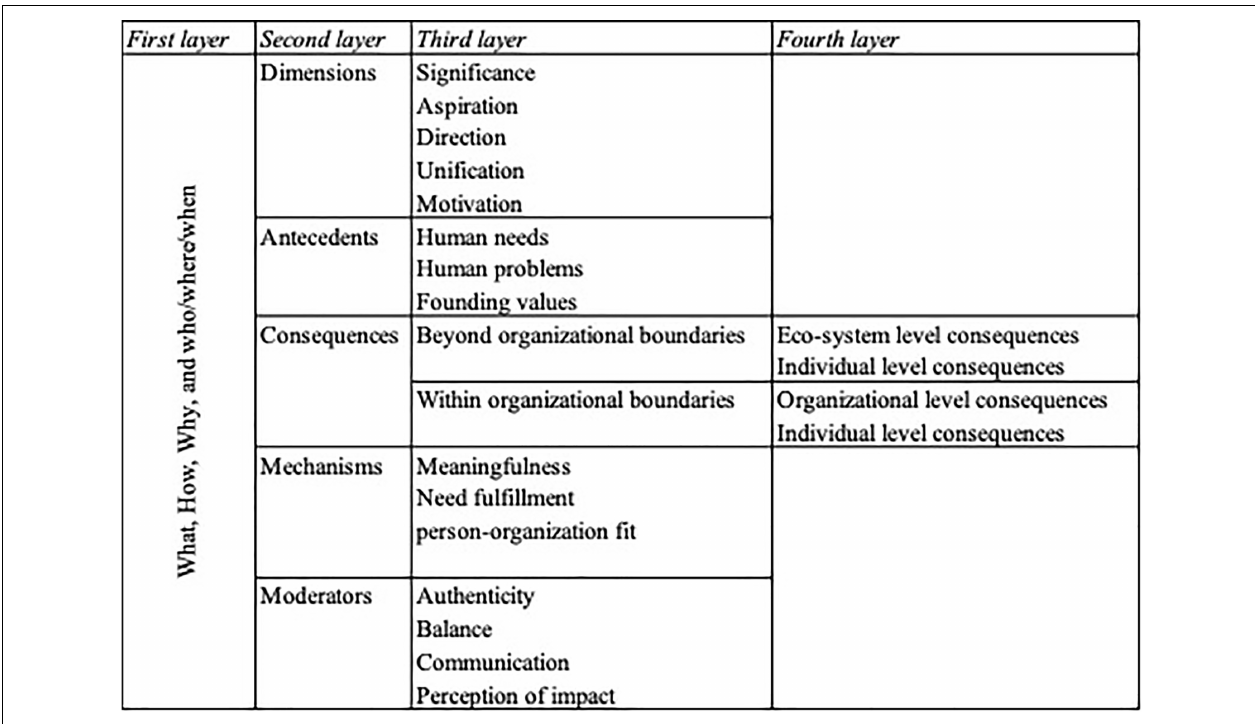
FIGURE 1 | Final template: dimensions, antecedents, consequences, mechanisms, and moderators of organizational